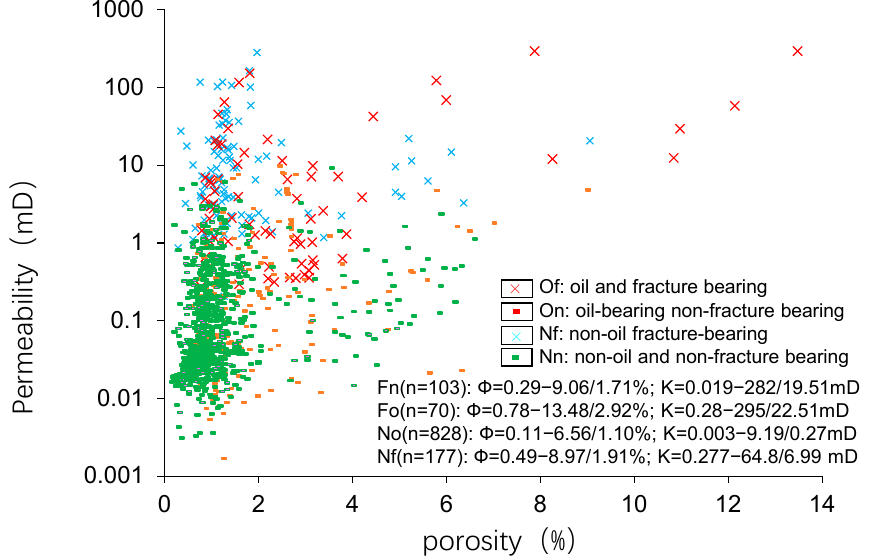
Figure 3. Correlation between core porosity and permeability in the strike-slip fault zone in the northern Tarim Basin (after reference [7]) .